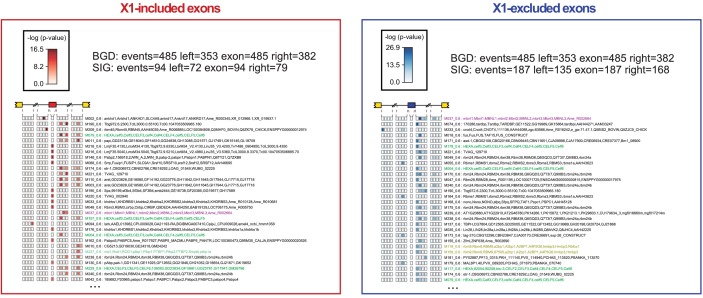
Enrichment of RBP binding motifs associated with neoblast-differential exons.Motif enrichment analyses for all RNAcompete-derived motifs (Ray et al., 2013) for neoblast-differential alternatively spliced exons with increased or decreased inclusion in X1 fraction. Each intronic box corresponds to a 20-nucleotide bin at the indicated location with respect to the AS exon. The whole exonic sequence was evaluated as a single bin. In each box, counts of the top 10% most strongly bound 7-mers were compared between the AS set of interest and a non-regulated background set. Colors encode significance of enrichment: log10 P-value Fisher's exact test.